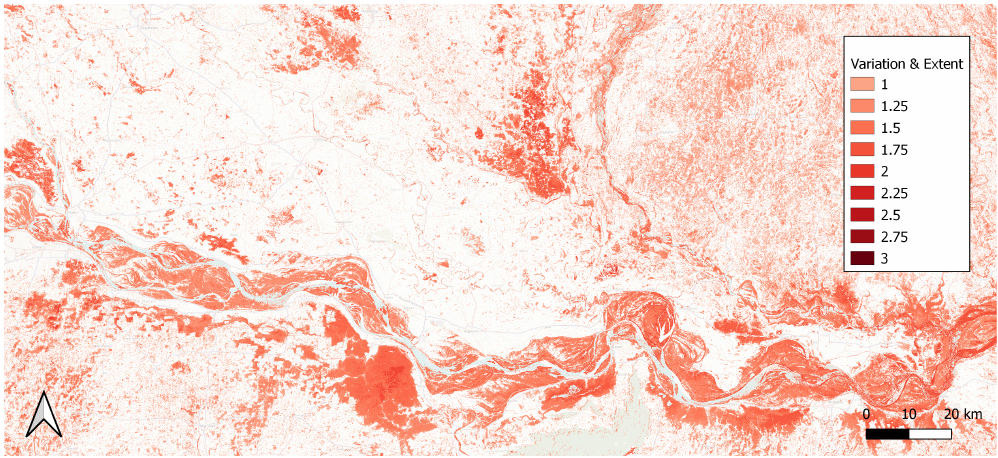
Figure 8. Unified flood map